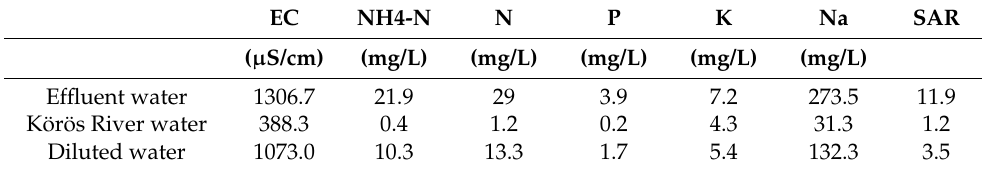
Table 3. Average major quality parameters of irrigation water used under experiment. EC